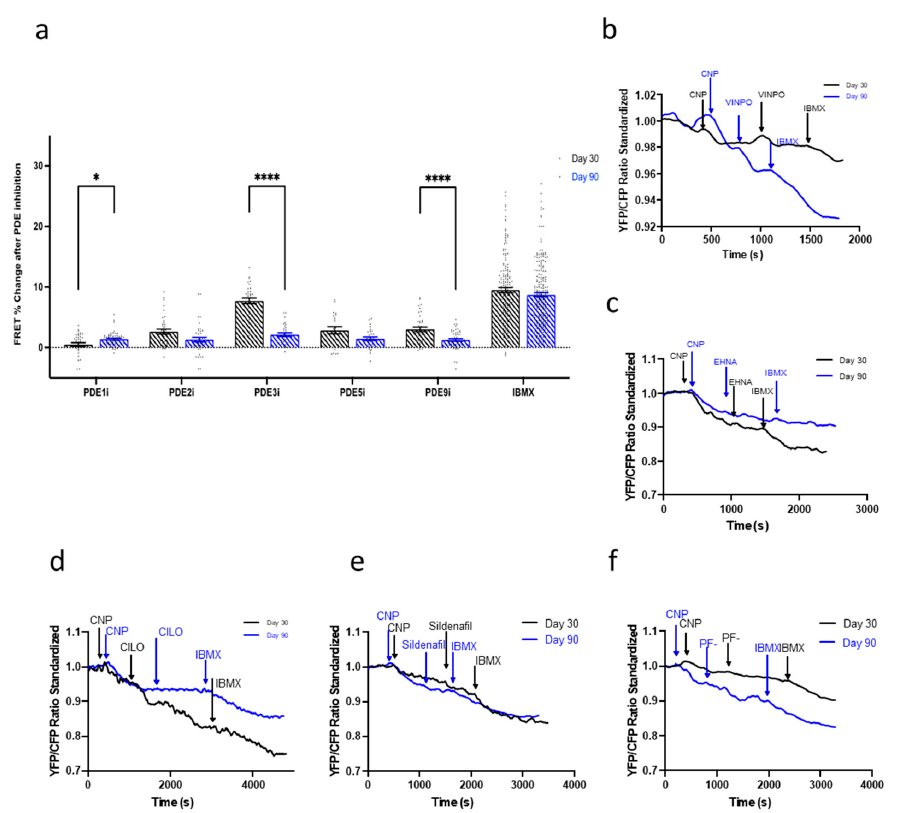
Figure 6. ( a ) Regulation of the natriuretic peptide receptor (NPR2)-C-type natriuretic peptide (CNP)-cGMP pathway by PDEs throughout the aging of IMR-hPSC-CMs in culture from day 30 to day 90. Model traces of cGMP production after the situation via CNP and subsequent ( b ) PDE1 inhibition via vinpocetine (VIMPO), ( c ) PDE2 inhibition via EHNA, ( d ) PDE3 inhibition via Cilostamine (CILO), ( e ) PDE5 inhibition via Sildenafil, and ( f ) PDE9 inhibition via PF-04447943 (PF-), and saturation via 3-isobutyl-1-methylxanthine (IBMX). All data is composed of three independent experimental batches. *—p < 0.1; ****—p < 0.0001